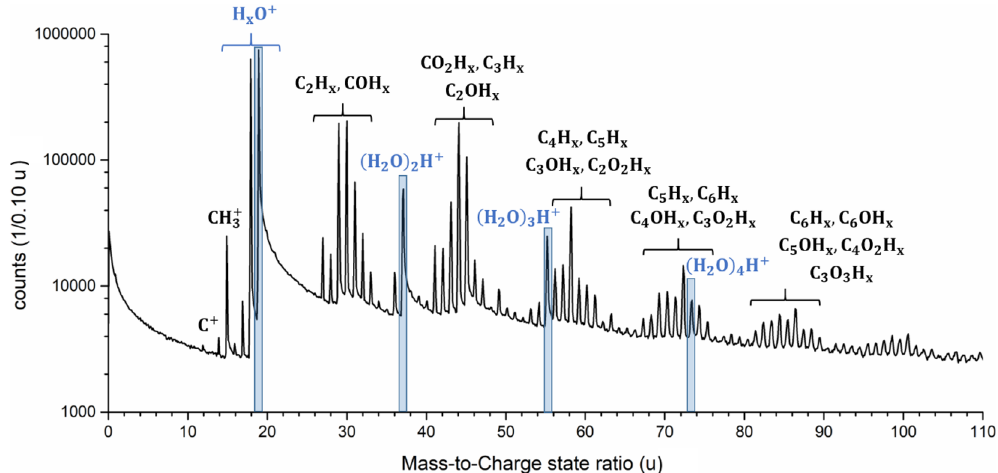
Figure 1. APT mass spectrum of honey with a mass-to-charge state ratio from 0 to 110 u as a logarithmic plot. The protonated water molecules/clusters with the molecular formula (H 2 O) n H + with n = 1–4 are highlighted. Different groups of peaks are